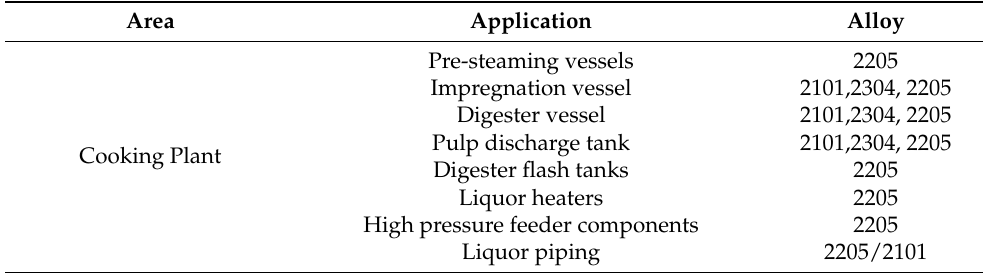
Table 5. The many uses of duplex stainless steel in Kraft pulp and paper mills